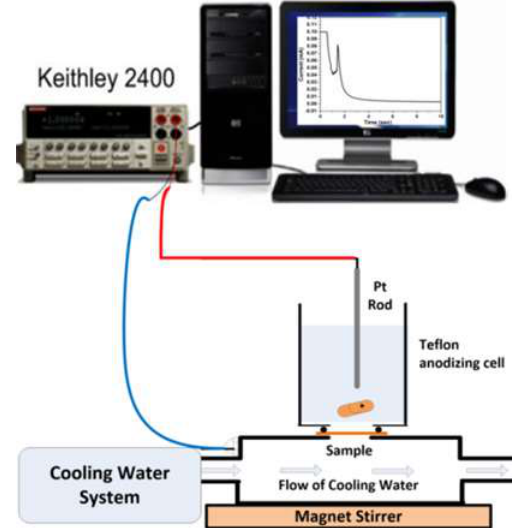
Figure: 1 Schematic diagram of experimental setup of